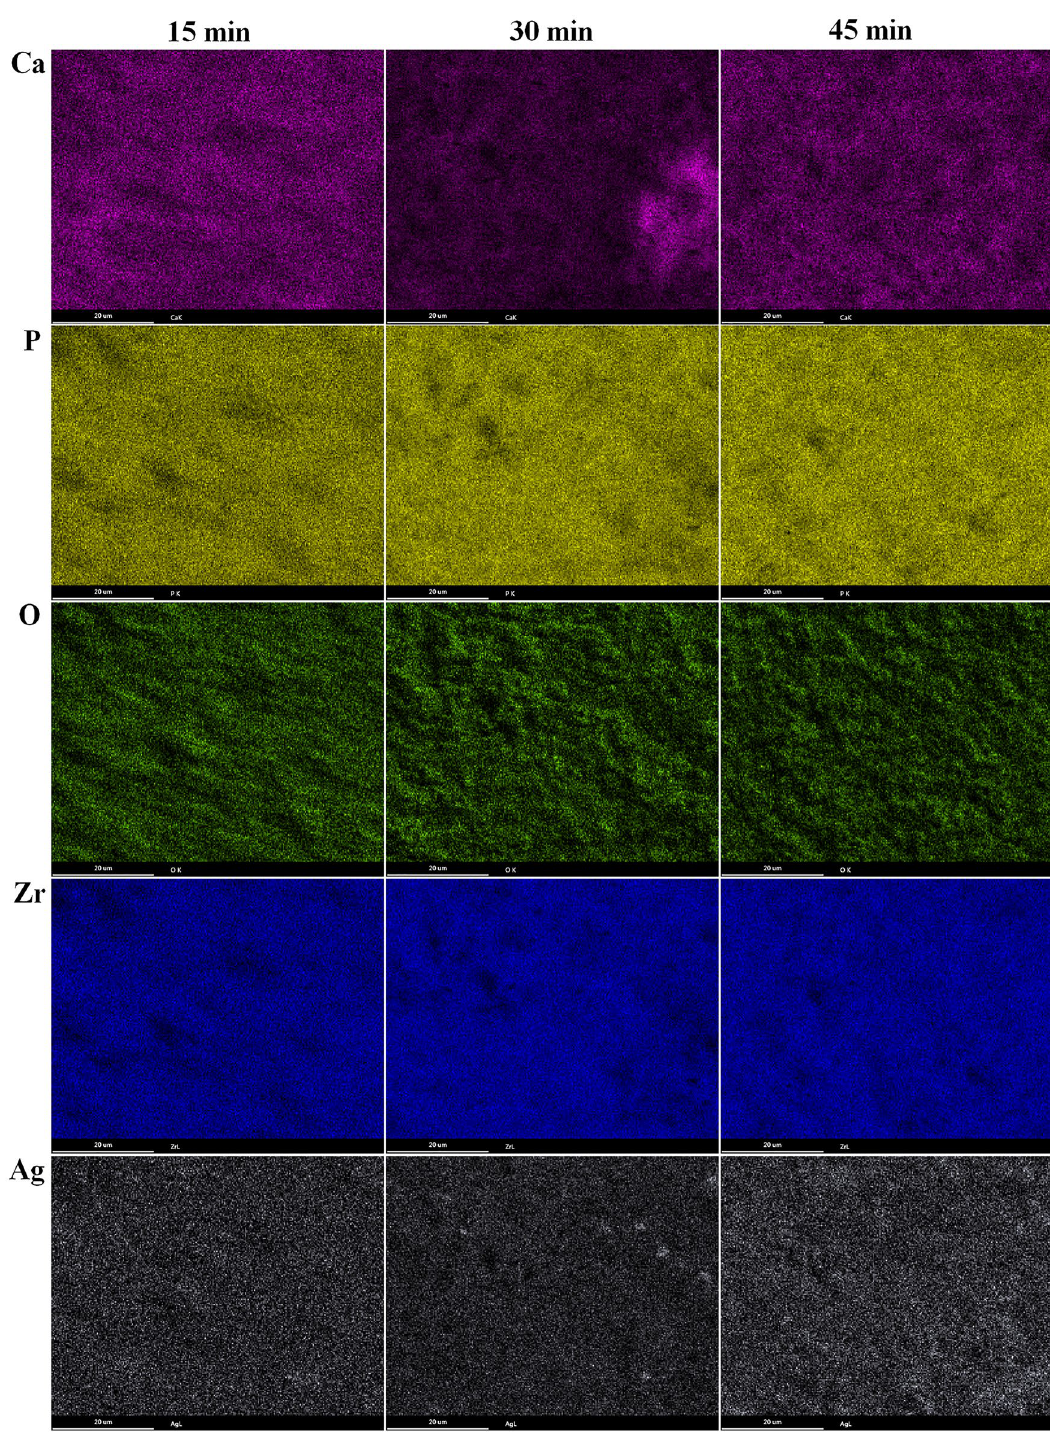
Figure 6. EDX-mapping images of AgNPs-doped MAO